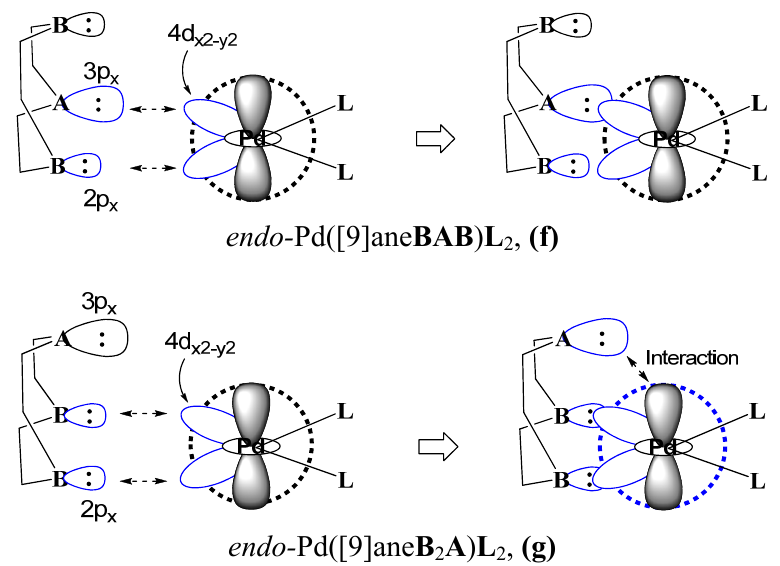
-orbital and x 2 -y 2 A ) L complexes. 2 2